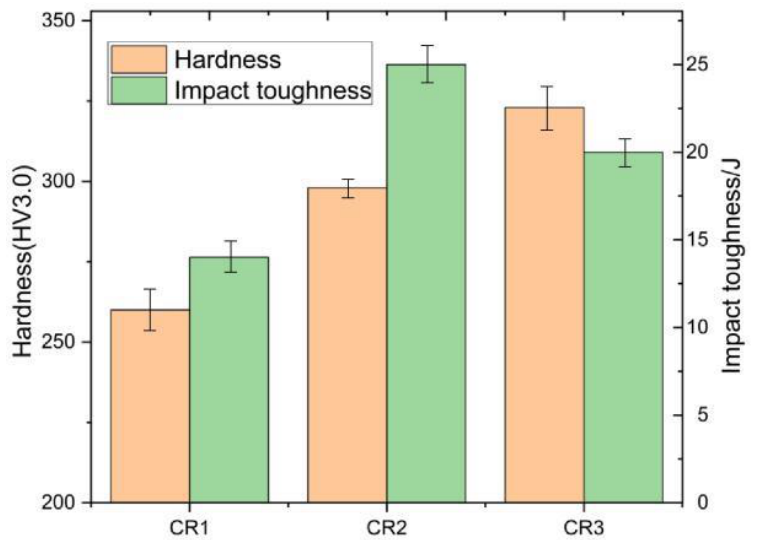
Figure 5. Mechanical properties of ICR CGHAZ under different cooling rates: Vickers micro-hardness and −40 °C impact energy.